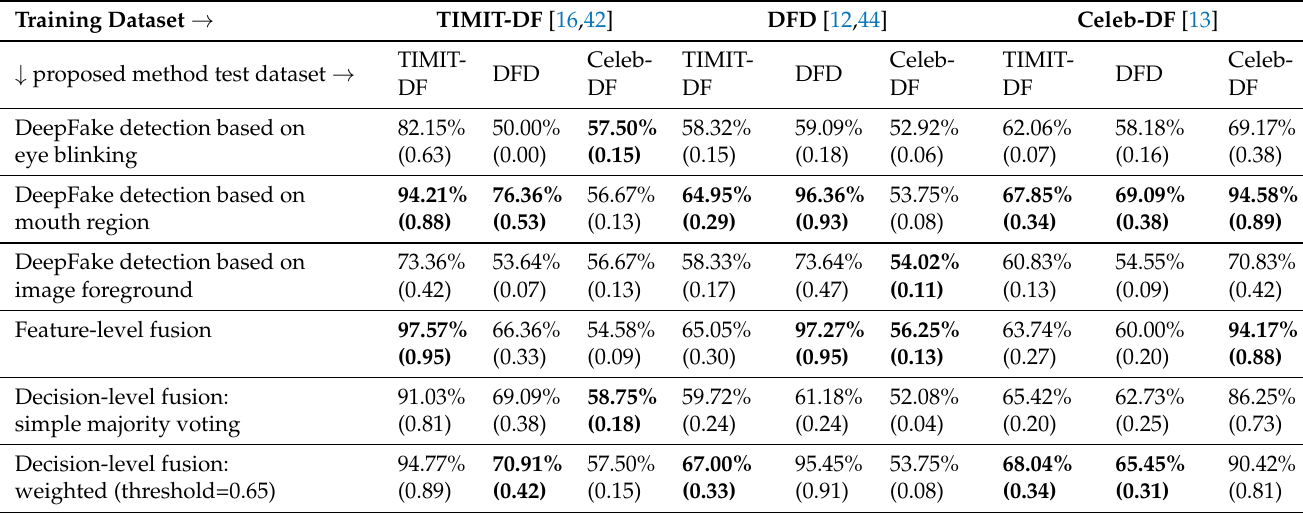
Table 7. Classification results based on accuracy in percent, followed by Cohen’s kappa in parenthesis, for the different methods proposed in this paper. Best result for each combination of training and test data is highlighted